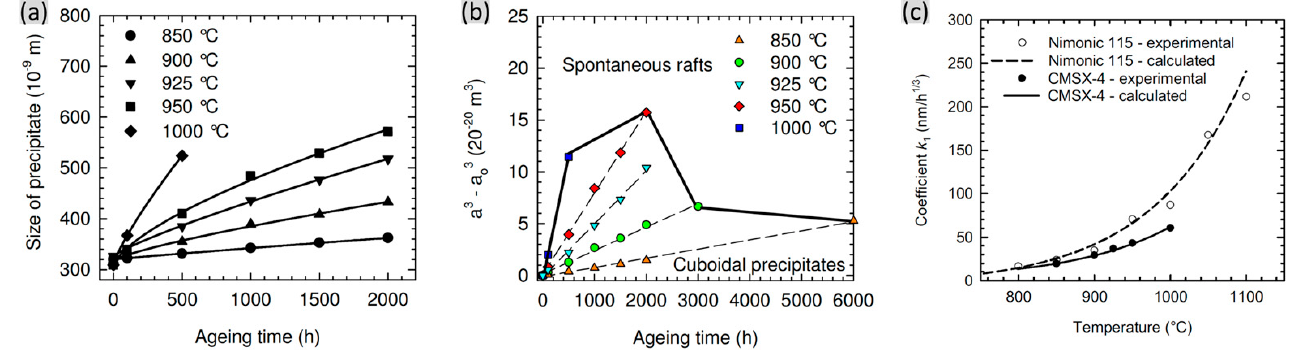
Figure 9. Dependence of the ( a ) average γ ’ size and ( b ) normalized γ ’ size as a function of thermal exposure time of CMSX-4 alloy after different durations at different temperature [53]. ( c ) Dependence of the coarsening rate as a function of temperature of two alloys